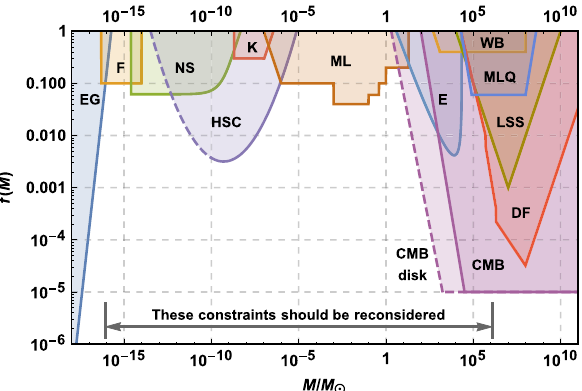
the initial one (filled gray area) to the final (solid black line). b Change of the total number of PBHs in the cluster due to merging and escape during the same period